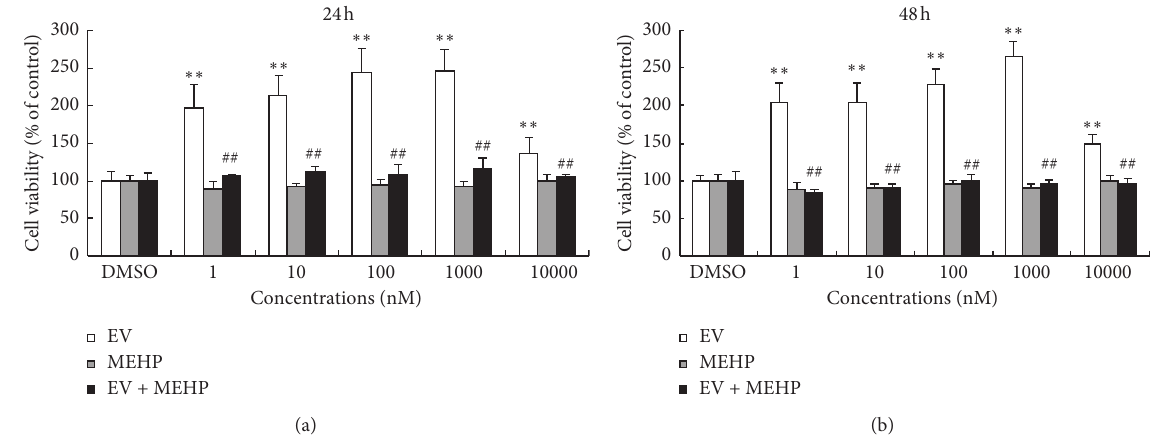
Figure 5: The binary joint effects of EV and MEHP on cell viability of MCF-7 cells. Exposure time: (a) 24h; (b) 48 h. Data points represent mean ± SD of three independent experiments with six replications. ∗ p < 0 . 05, ∗∗ p < 0 . 01, compared with DMSO; ## p < 0 . 01, compared with EV